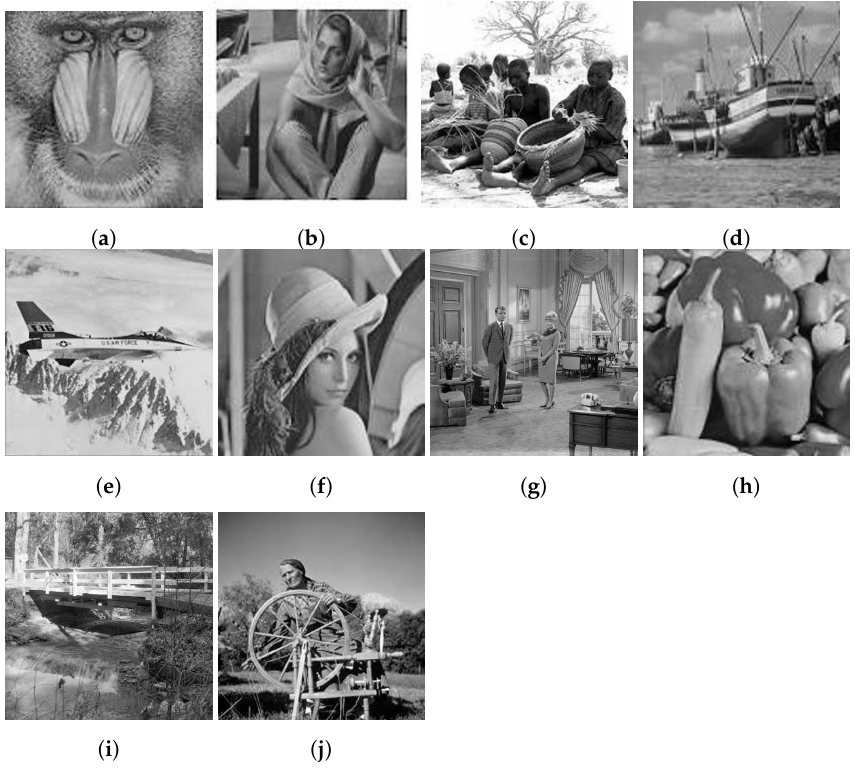
Figure 5. Stego images for the corresponding cover images: ( a ) Baboon, ( b ) Barbara, ( c )